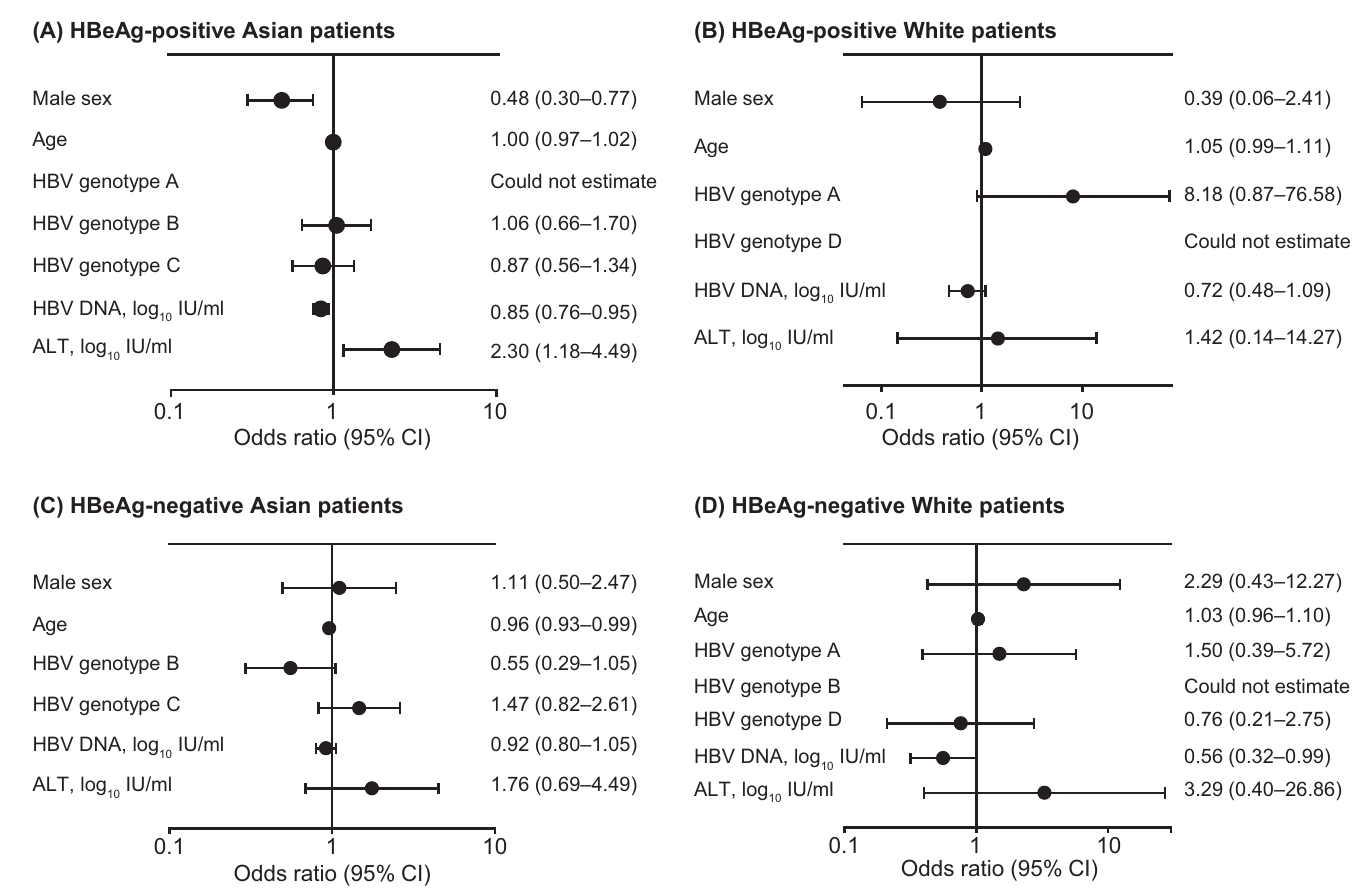
Fig 2. Associations between baseline covariates and treatment outcome in univariate logistic regression analyses. Associations are shown for HBeAg-positive Asian (A) and white (B) patients, and in HBeAg-negative Asian (C) and white (D) patients. ALT, alanine aminotransferase; HBeAg, hepatitis B e antigen; HBV, hepatitis B virus. After adjusting for significant baseline covariates, there were no statistically significant associations between IFNL3 genotypes and response in the final logistic regression models (Fig